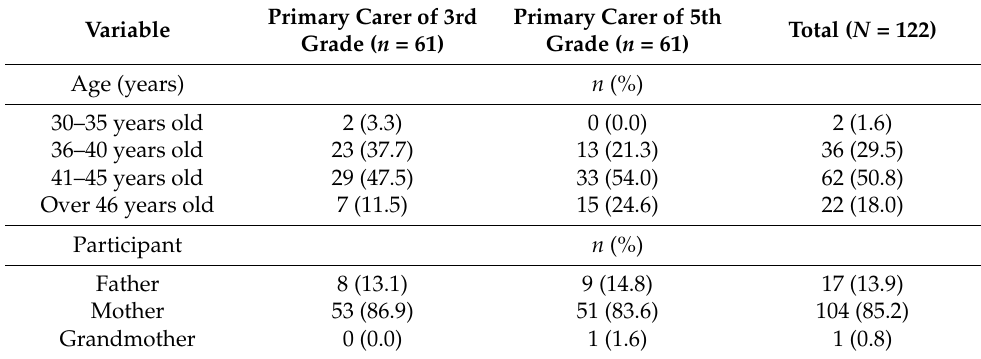
Table 4. Descriptive characteristics of the participating primary carers ( N =